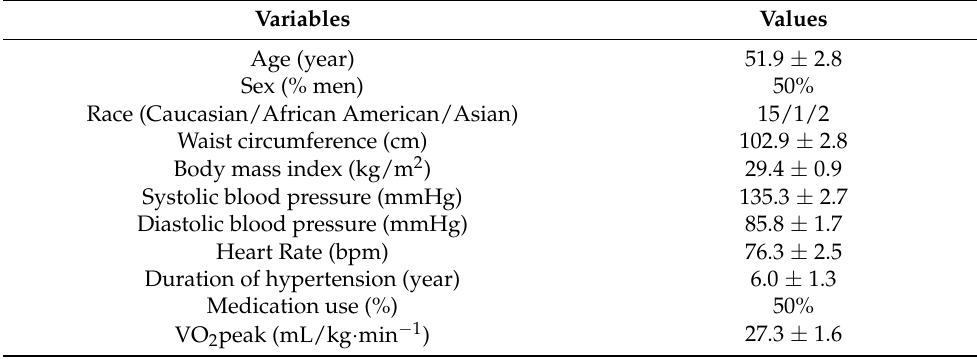
Figure 1. Study design overview. BMI, body mass index; BP, blood pressure; GEST, graded exercise stress test; HRR, heart rate reserve; HRV, heart rate variability; PEH, postexercise hypotension; WC, waist circumference. Table 1. Baseline participant characteristics ( n = 18, mean ± SEM).